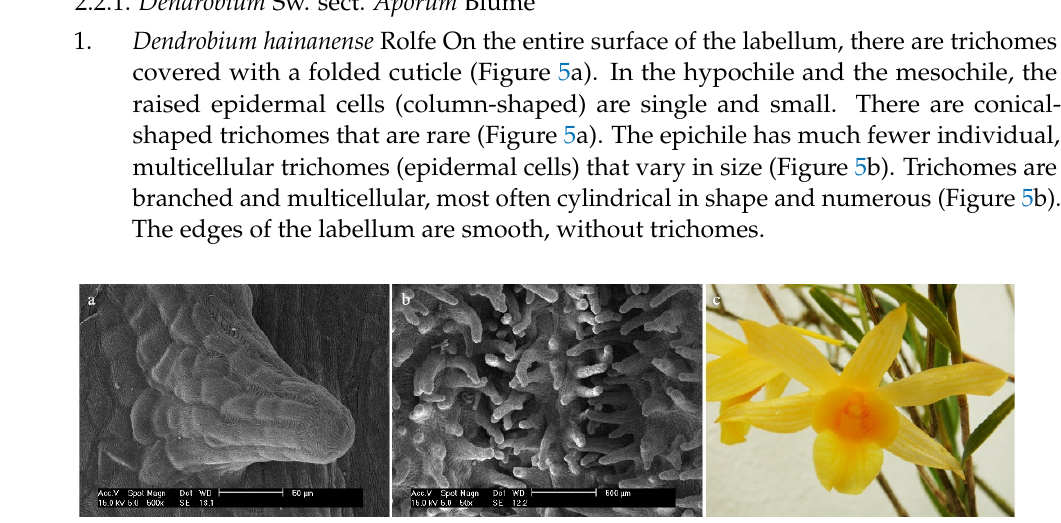
Figure 5. Dendrobium hainanense Rolfe.: trichomes ( a ) of the hypochile part of the labellum; ( b ) of the epichile part of the labellum; ( c ) flower (photo by Monika Lipi ń ska).